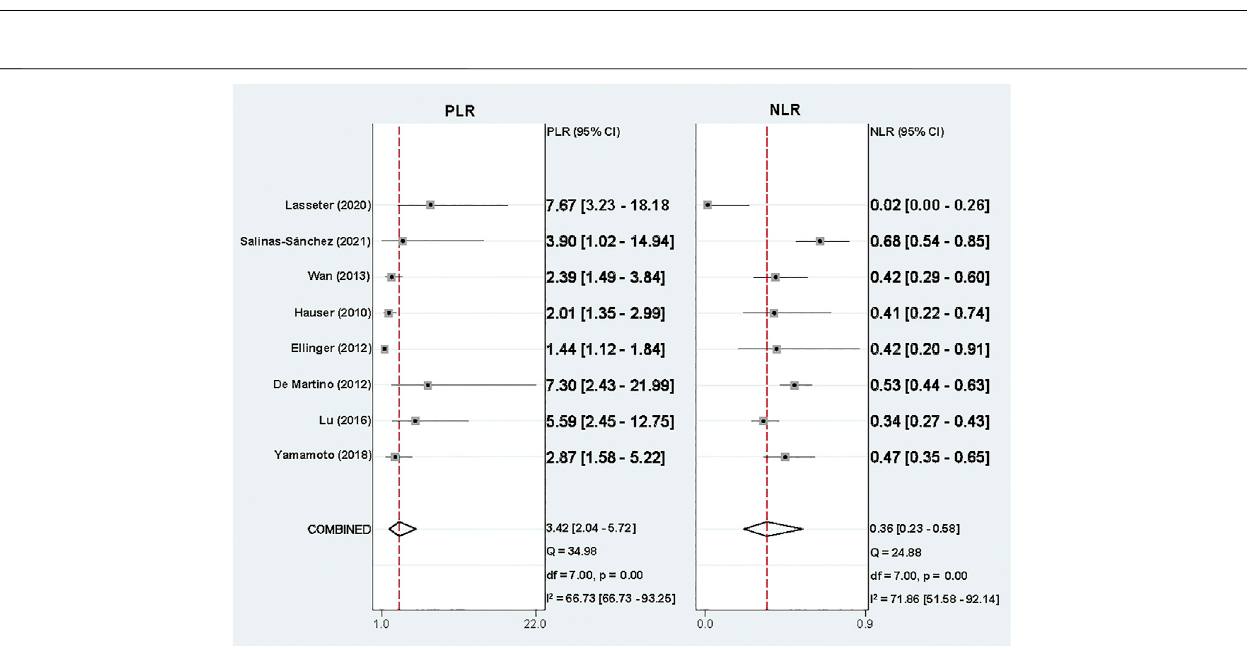
FIGURE 4 | Forest plot of positive likelihood ratio and negative likelihood